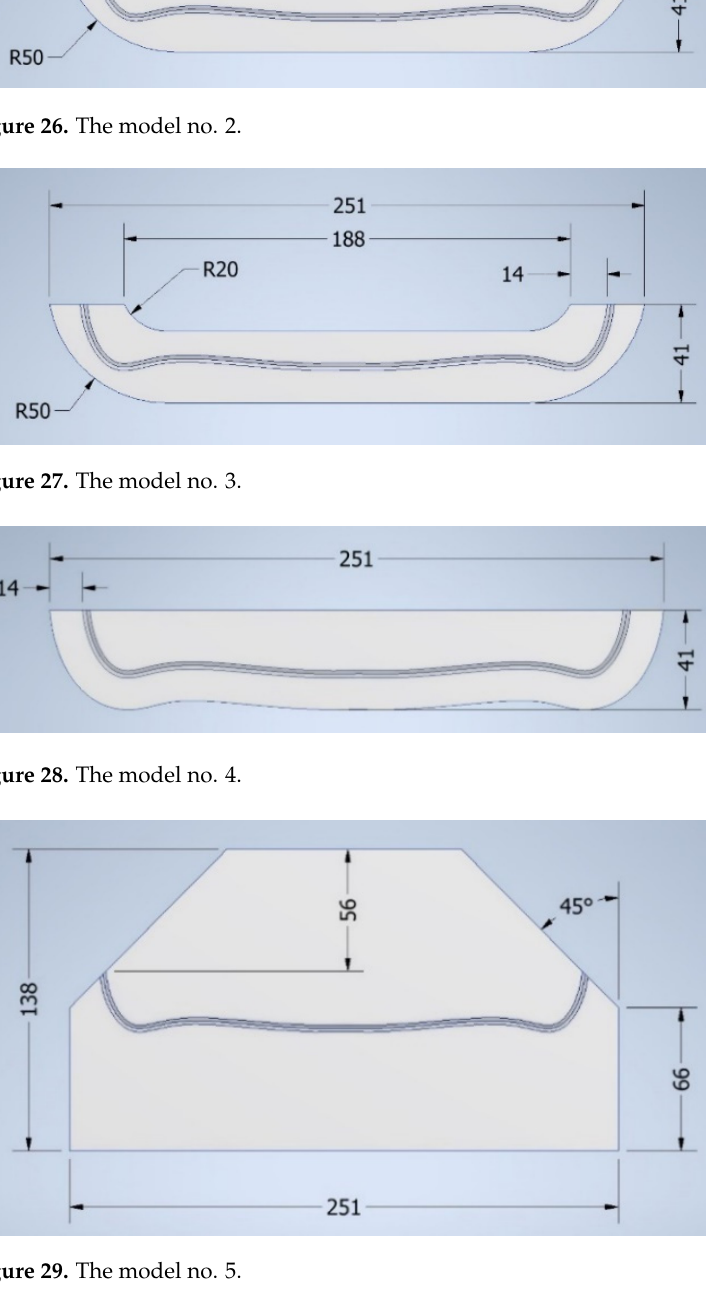
(Figures 30b, 31b, 32b, 33b and 34b were